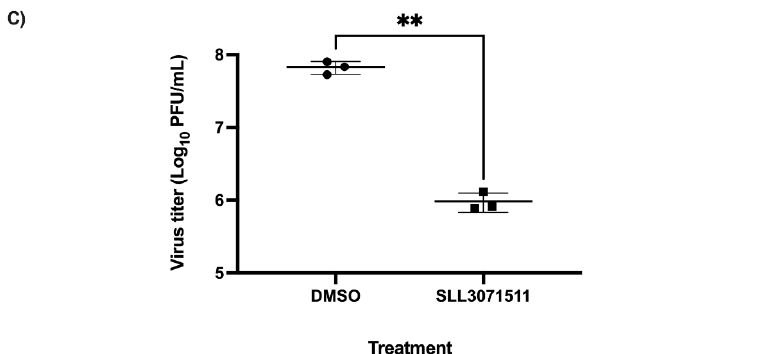
Figure 3. Early treatment with SLL3071511 significantly decreases viral RNA production virus release following infection. ( A ) HeLa cells were mock−infected or infected with CHIKV (MOI = 1) either 1 h post−treatment, concurrent with treatment or 1 h pretreatment with DMSO or SLL3071511. At 24 hpi, staining was carried out for the viral nonstructural protein (nsP3, green), cell nucleus (Hoechst33342, blue), and cell cytoplasm (CellMask, red). Images were obtained on the Operetta CLS confocal microscope (20× objective) and analysis was conducted using the Harmony software. ( B ) HeLa cells were mock-infected or infected with CHIKV at an MOI of 1 following a 1-h pretreatment with DMSO or SLL3071511 (20 µ M). At 24 hpi, cells were harvested, and RNA was isolated, followed by cDNA synthesis. qPCR was conducted and log fold change of the nsP1 expression was calculated using the 2 − ∆∆ Ct method with GAPDH as the housekeeping gene. ( C ) HeLa cells were mock-infected or infected with CHIKV at an MOI of 1 following a 1-h pretreatment with DMSO or SLL3071511 (25 µ M). At 24 hpi, plaque assay was carried out using supernatant from the samples. Data represent the means ( ± SD) from one representative experiment of at least two independent experiments performed in duplicate. Statistical analyses were determined using unpaired Student’s t -tests, and significant differences are indicated by ** ( p < 0.005), **** ( p <